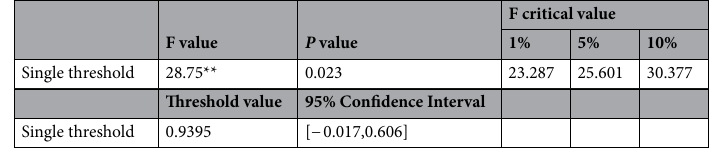
Table 10. Threshold test.